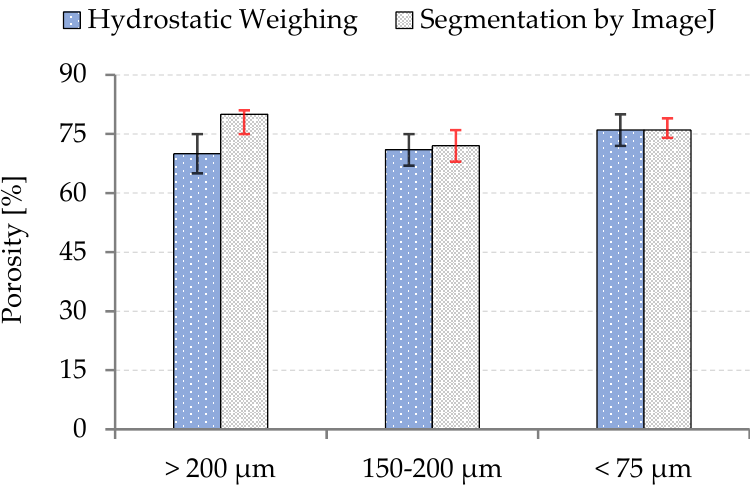
Figure 4. The porosity analysis of the prepared porous structures.